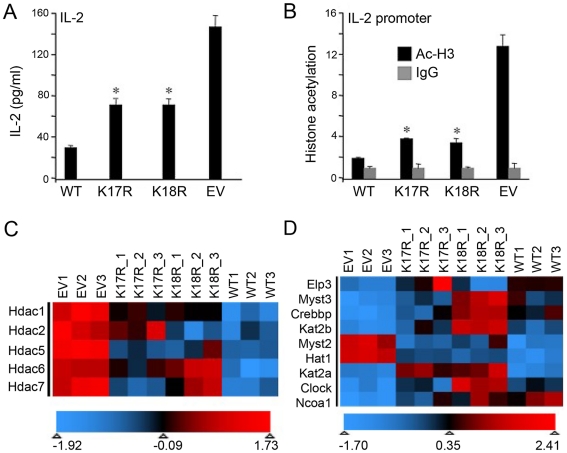
Foxp3 mutations affect chromatin remodeling and HDAC and HAT expression.CD4+ T cells transduced with WT Foxp3, K17R, K18R or EV were cultured in medium with CD3/CD28 mAb for 20 h. (A) IL-2 levels were detected by ELISA. (B) Chromatin extracts were precipitated with anti-AcH3 Ab or control IgG, and probed for the promoter regions of IL-2 and genes levels were determined by qPCR. Results (mean ± SD) in panels A and B are representative of 3 independent experiments, and *p<0.05, **p<0.01 compared to WT Foxp3. Heat maps indicating distinct expression profiles of genes encoding (C) HDAC and (D) HAT enzymes. Microarray experiments were performed using whole-mouse-genome oligoarrays (Mouse430a; Affymetrix), and array data were analyzed using MAYDAY 2.12 software [45]. Array data were subjected to robust multiarray average normalization. Normalized data were used for calculating fold changes of up- and downregulated genes using Student's test, and data with >2x differential expression (p<0.05 with Storey's FDR<0.1) were included in the analysis. Data underwent z-score transformation for display.